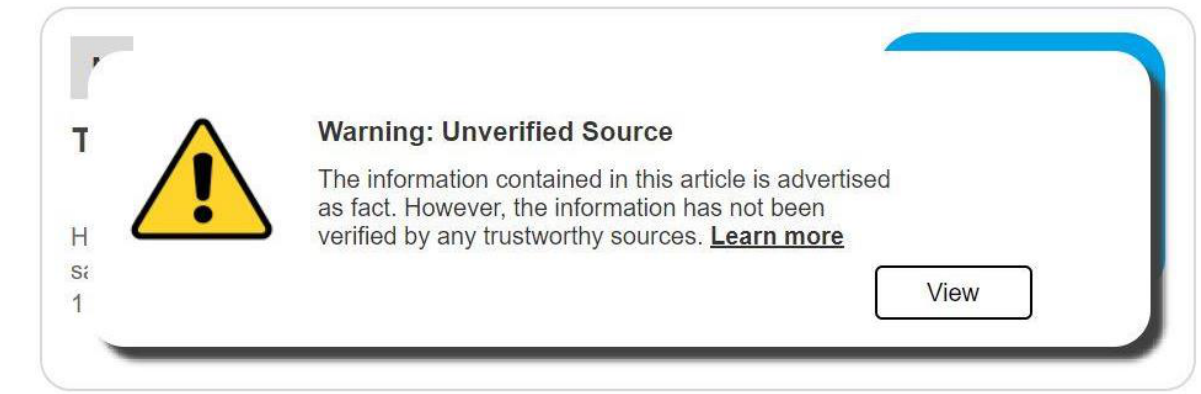
Figure 52. Warning label 1 [16].